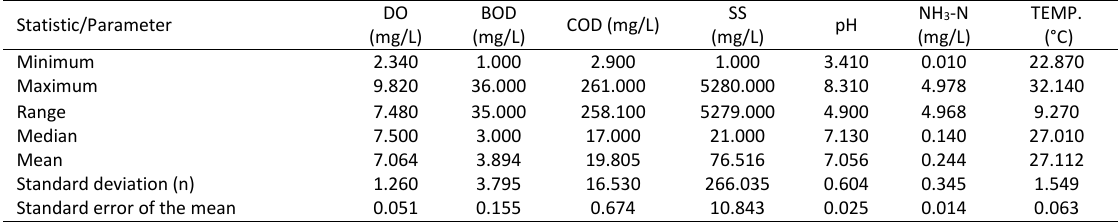
Table 4: Results of MK trend test of water quality parameters at the stations (2005-2015)